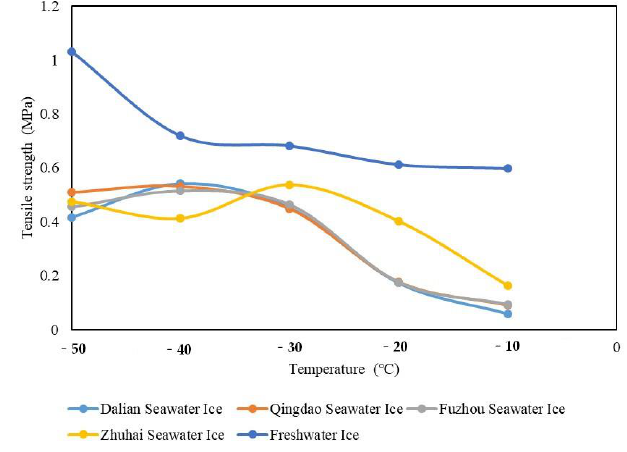
Figure 23. Comparison of tensile strength between seawater ice and freshwater ice. Figure 24. Comparison of tensile strength between seawater ice and freshwater ice.